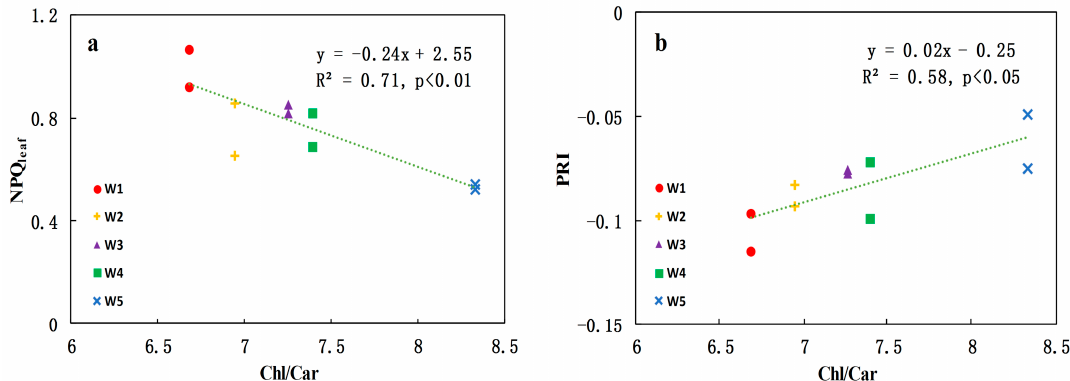
Figure 2. ( a ) The relationships between leaf-level non-photochemical quenching (NPQ leaf ) and the ratio of chlorophyll to carotenoid (Chl/Car) and between ( b ) photochemical reflectance index (PRI) and Chl/Car at different soil moisture levels.